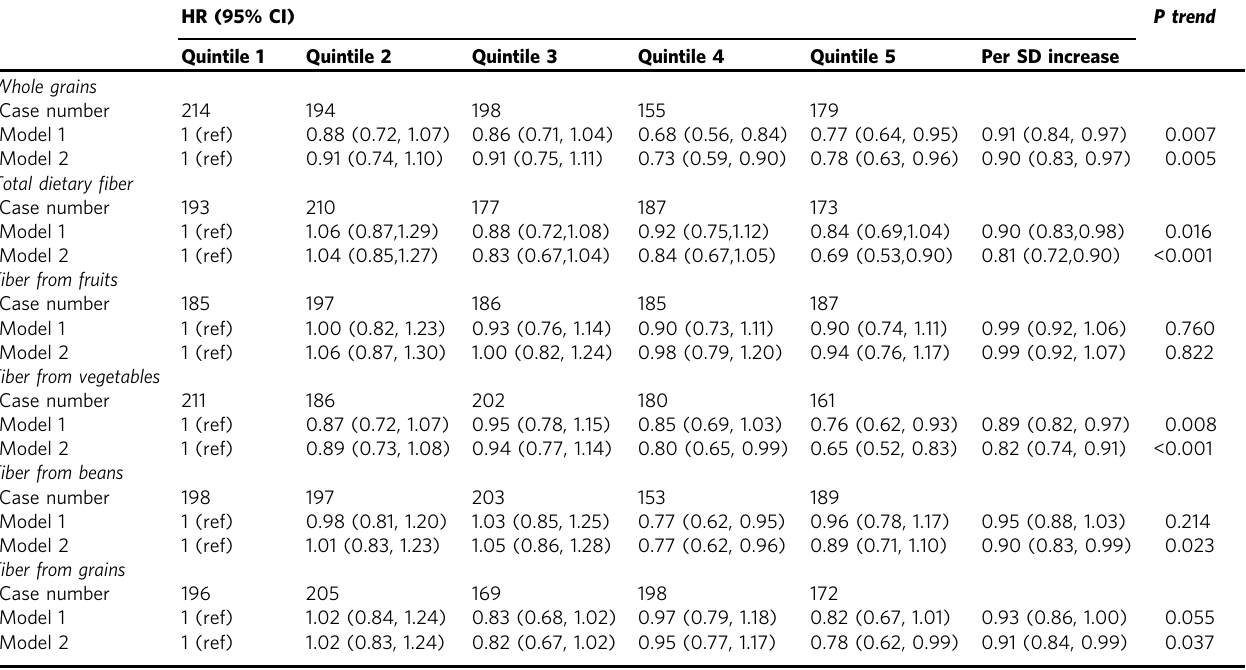
Table 2 The associations between whole grains and dietary fi ber with risk of liver cancer from the NIH – AARP Diet and Health